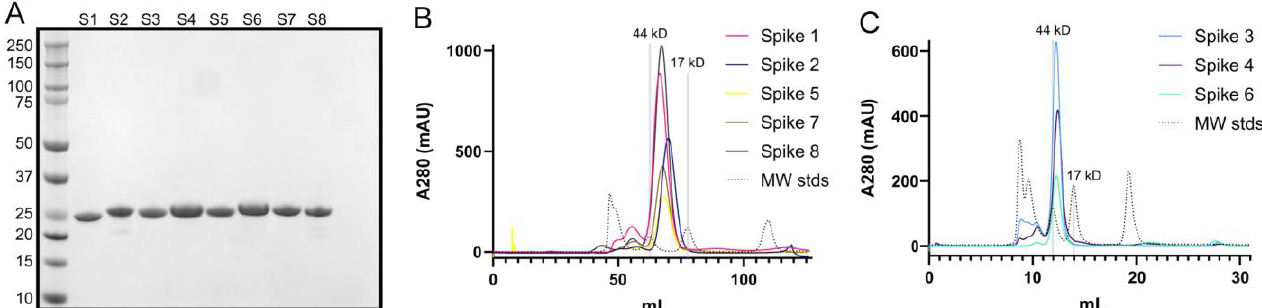
Figure 2. Purification of recombinant human astrovirus 1–8 capsid spikes (Spike 1–Spike 8). ( A ) Reducing SDS-PAGE of purified recombinant Spikes 1–8 (S1–S8). ( B ) Size exclusion chromatography column (Superdex 75 16/600) traces of Spikes 1, 2, 5, 7, and 8. ( C ) Size exclusion chromatography column (Superdex 75 10/300) traces of Spikes 3, 4, and 6. Size-exclusion chromatography confirmed that the purified spikes are folded and form dimers in solution.